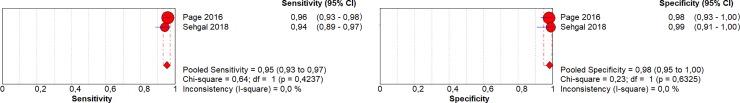
Forest plot of sensitivity (A), specificity (B), and heterogeneity from the ELISA test for the subgroup analyses (two studies with commercial tests).